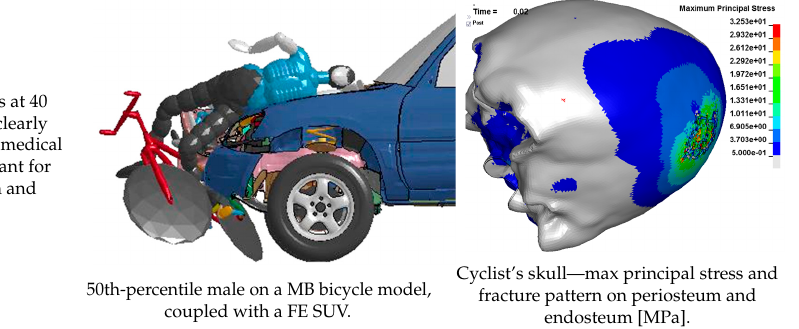
Cyclist’s skull—max principal stress and fracture pattern on periosteum and endosteum